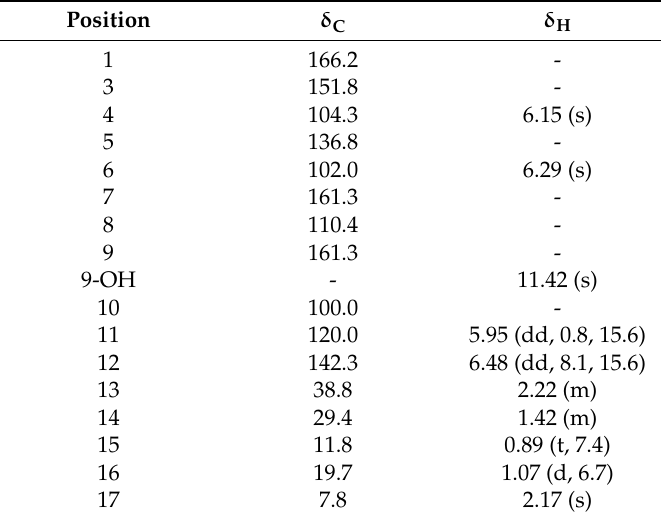
Table 1. NMR spectroscopic data of 1 in CDCl 3 .